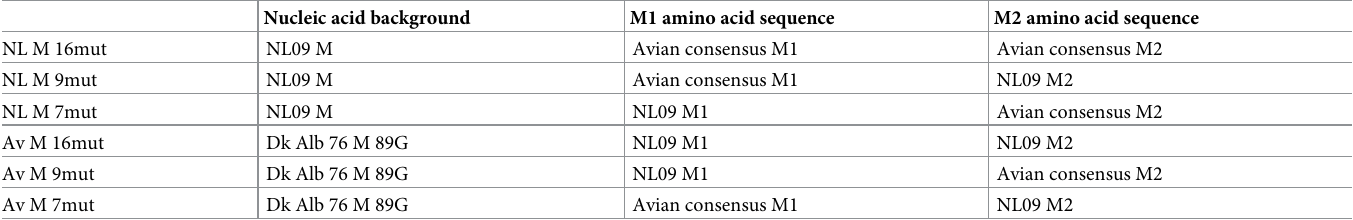
Table 2. Genotypes of avian-human chimeric M segments. Nucleic acid